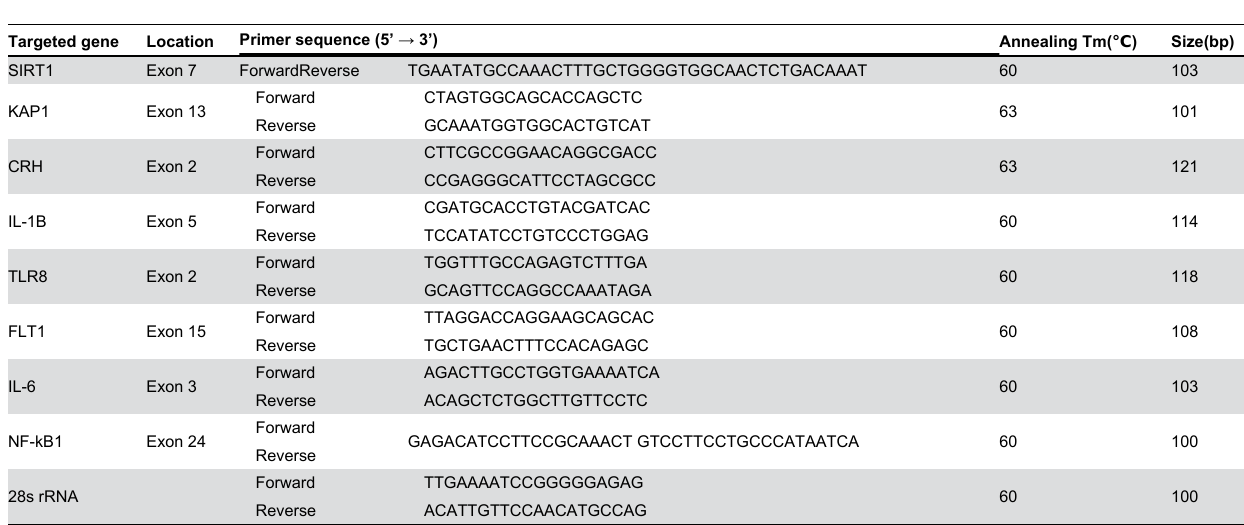
Table 2. Sequences of oligonucleotide primers used to amplify target genes and expected RT-PCR product sizes.